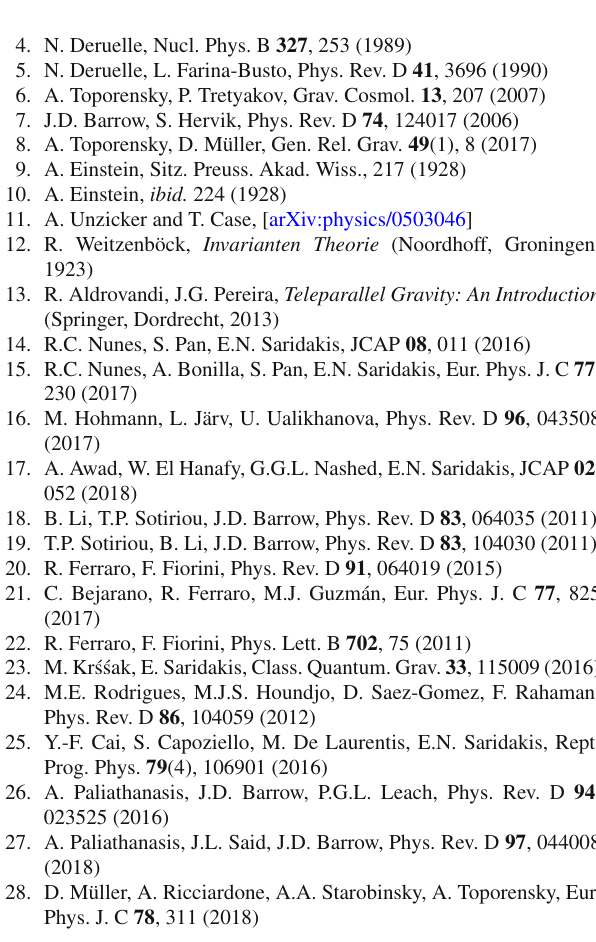
Fig. 7 The evolution of sums P 1 + P 2 + P 3 (left) and ( P 1 ) 2 + ( P 2 ) 2 + ( P 3 ) 2 (right) for N = 2, f 0 = − 1 chosen as in Fig. 6 (see the corresponding colors of solid curves). The black star denotes the moment of a cosmological singularity in the